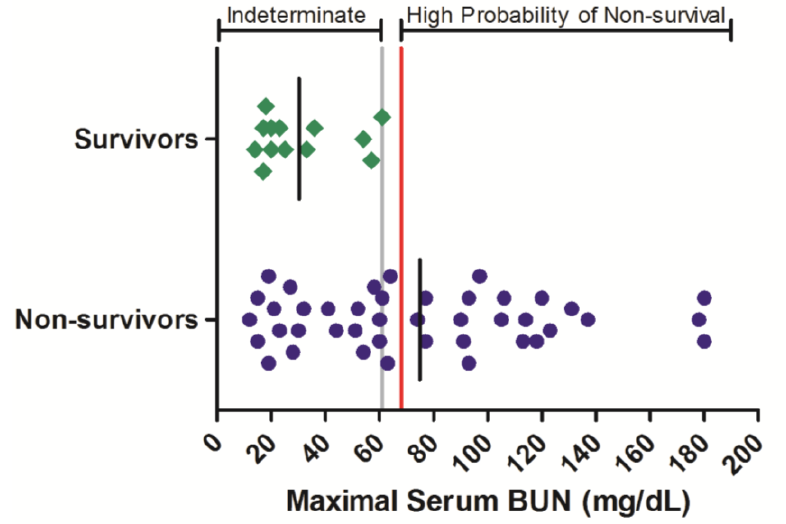
Figure 1. Serum BUN responses in rhesus monkeys exposed to Ebola virus. Symbols represent the maximal serum BUN value obtained at any time during the course of infection for an individual animal (diamonds = survivors, circles = non-survivors). Data were compiled from multiple independent historic experiments. The horizontal gray line indicates a survival threshold, i.e. , the maximal value obtained in any animal that survived infection. The red line indicates a proposed euthanasia threshold value based on ROC curve suggested values plus 10%. Black lines are the group mean. Normative serum BUN reference range for rhesus monkeys (mean +/− 1 SD) is 15–21 mg/dL